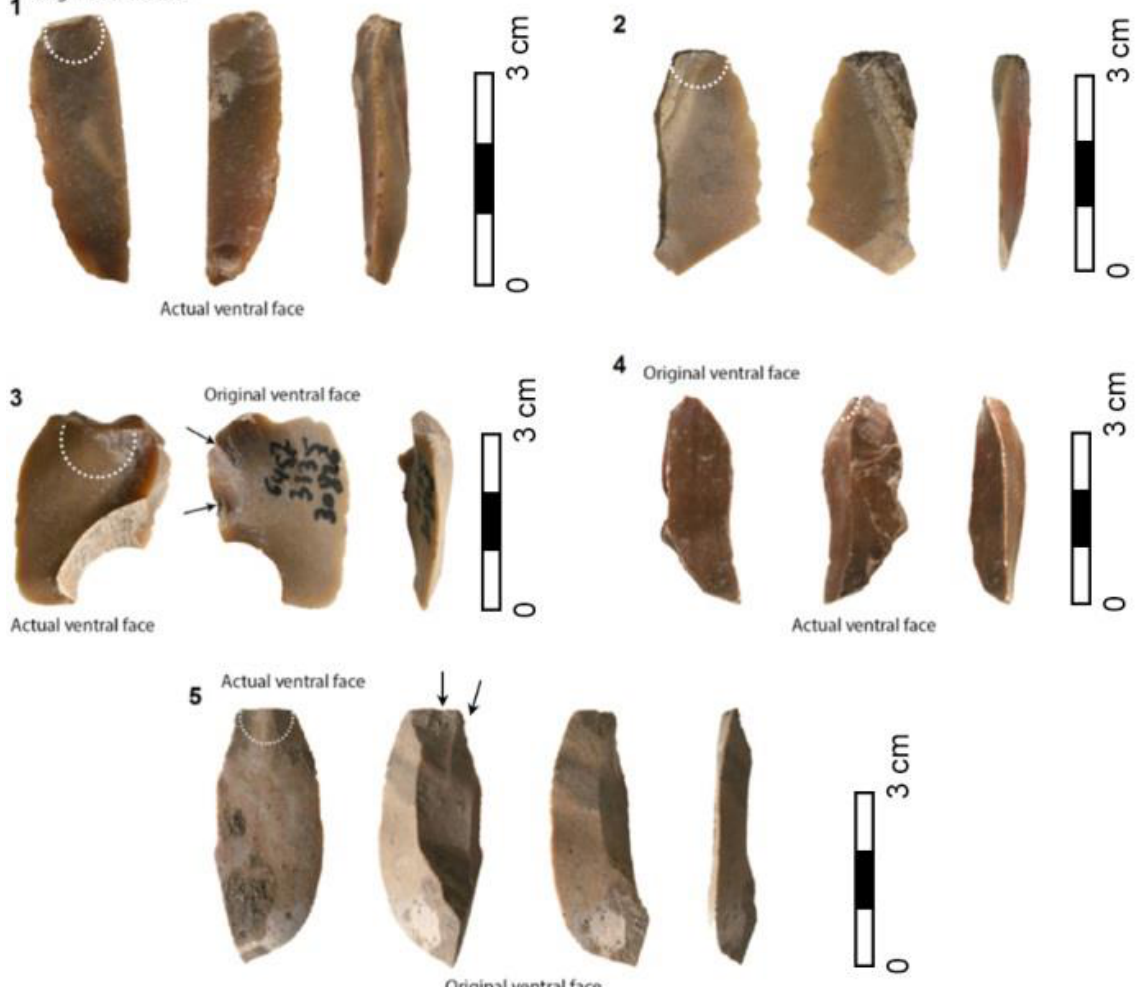
Figure 11. Lateral items: 1 & 2 are lateral items with plain dorsal faces; 3 & 5 are lateral items with previous removals on their dorsal faces; 4 is a lateral item with previous retouch. Dotted white lines denote the bulb of percussion; black arrows denote previous